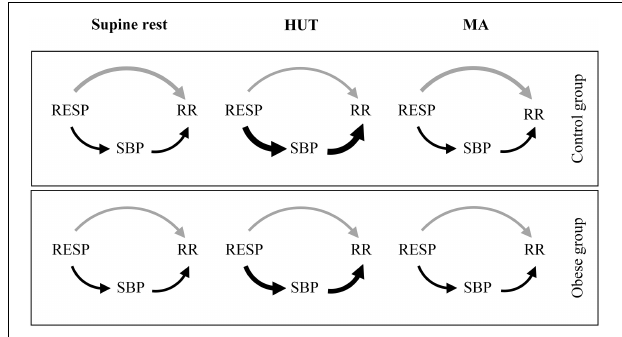
FIGURE 3 | Proposed causal interaction models of RSA mechanisms during supine rest, HUT, and MA. The arrow thickness reflects the strength of the causal coupling in the given direction, with changes in thickness corresponding to statistically significant variations between groups or conditions. The gray arrow represents the direct effects of RESP on RR (U RESP → RR ; strength of non-baroreflex RSA mechanisms) and the black arrows represent the effects of RESP on RR mediated through SBP (R RESP , SBP → RR ; strength of baroreflex RSA